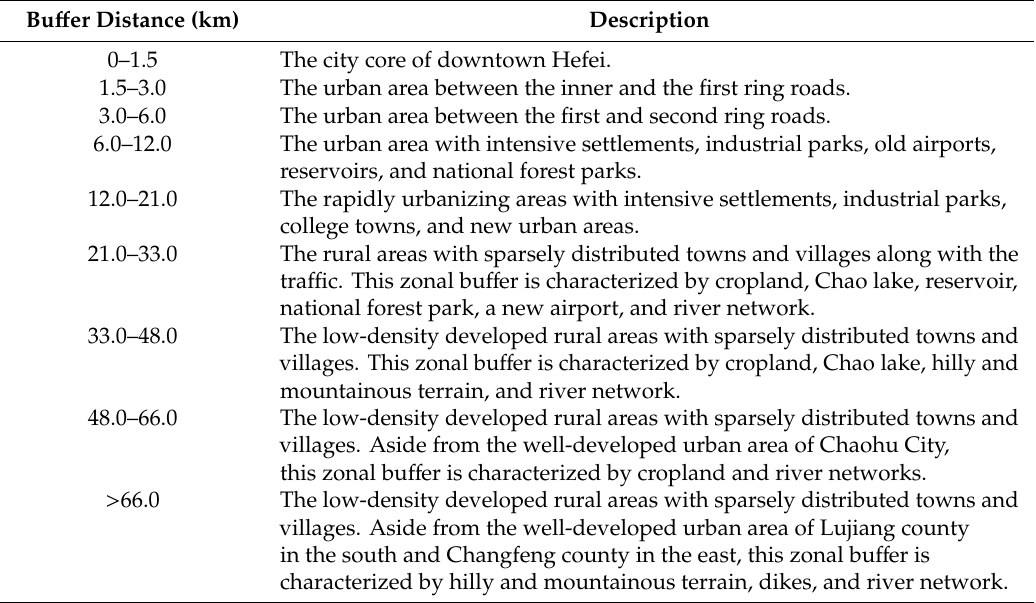
Table 2. Description of concentric bu ff ers drawn along the urban–rural